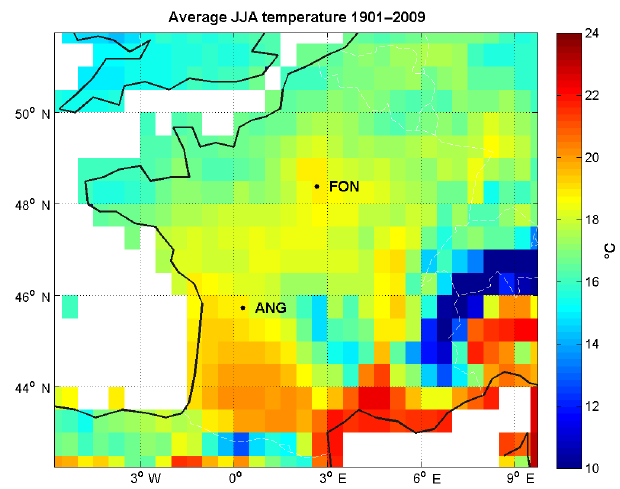
Figure 1. Map of France showing the locations of the tree ring chronologies from Fontainebleau (FON) and Angoulême (ANG). The color scale indicates the average summer (June–August) sur- face air temperature